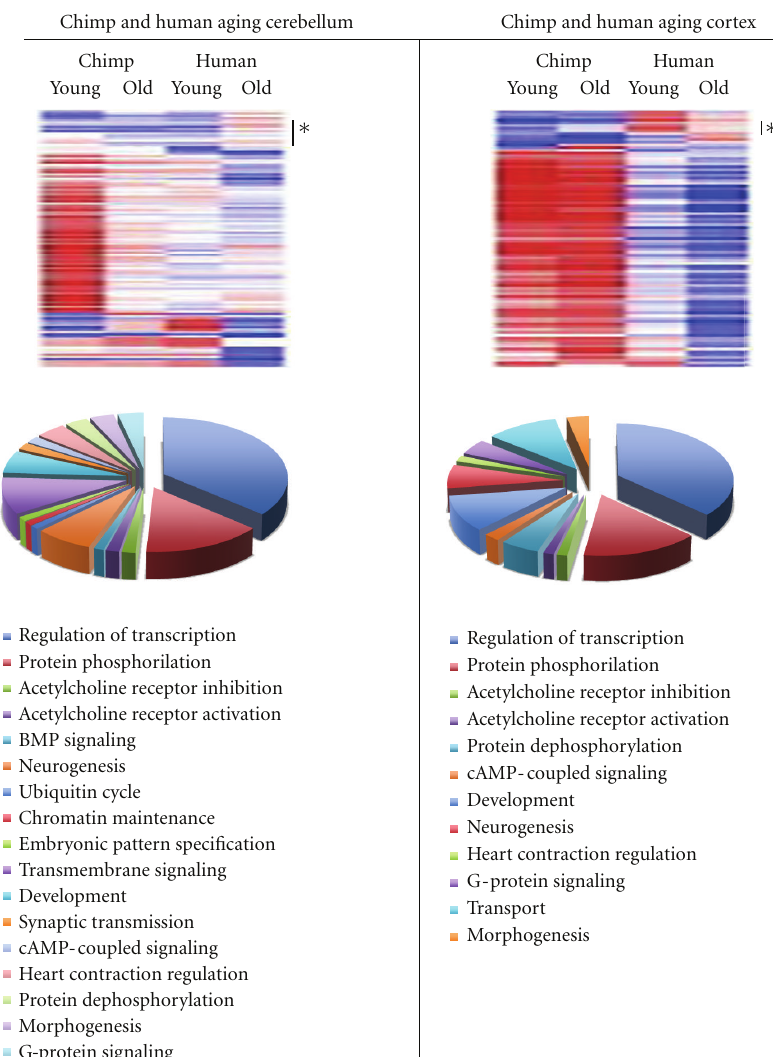
Figure 1: Expression of selected miRNAs is induced in the aging cerebellum and cortex of chimpanzees and humans. The asterisks indicate groups of miRNAs and ncRNAs that are specifically upregulated in the aging human cerebellum and cortex. Ontology analysis for biological function of the human upregulated miRNA target genes in the cerebellum and cortex of aged individuals is shown below the